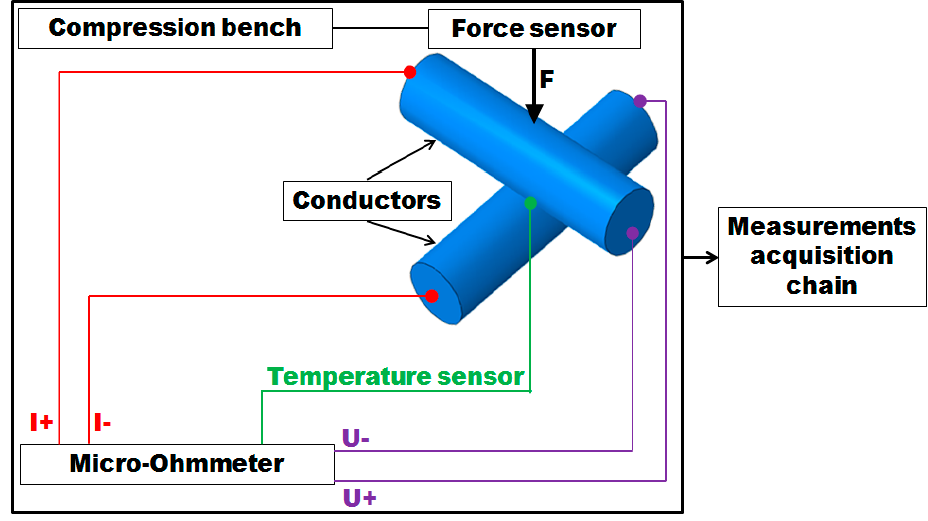
Figure 1. Diagram of the experimental